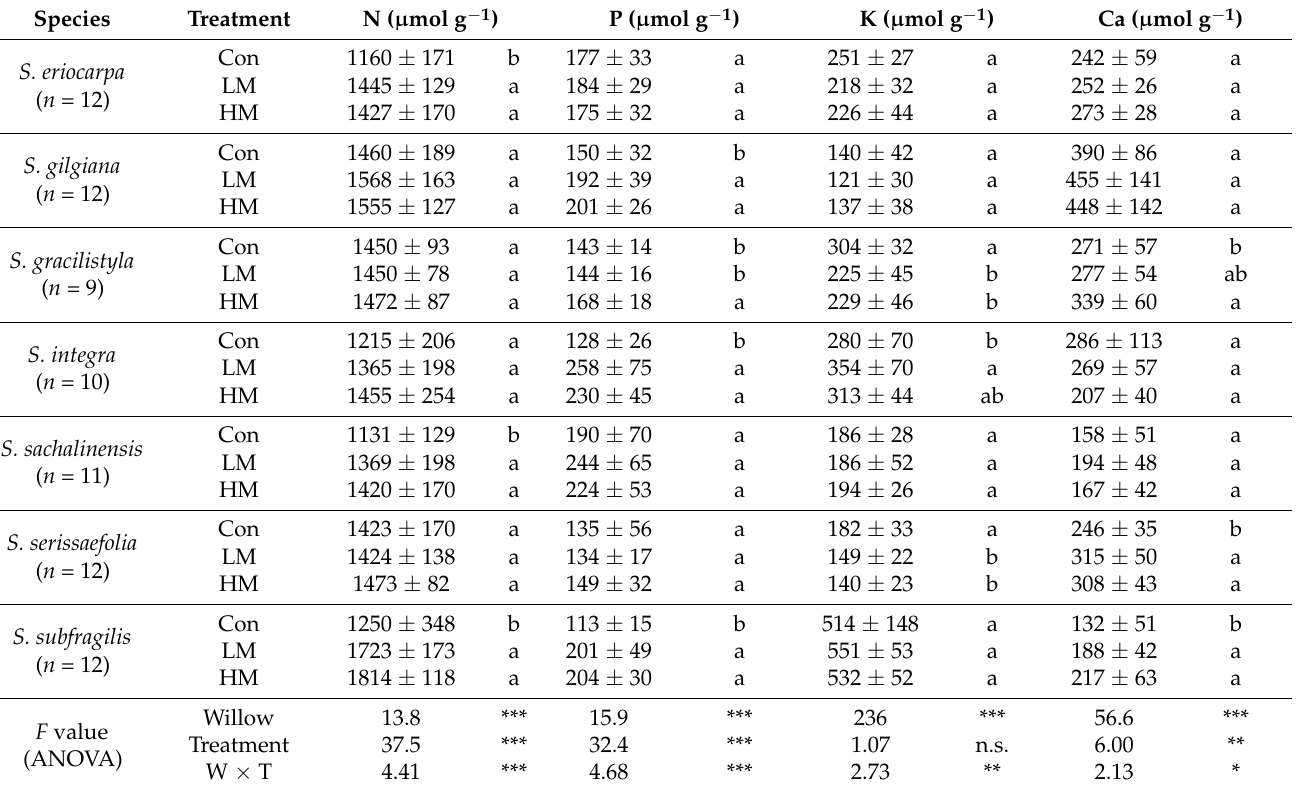
Table 6. Concentrations of chemical elements N, P, K and Ca (dry mass) in the leaves of individuals of seven willows grown under three treatments (mean ± SD). Asterisks indicate significant differ- ences among seven willows, three treatments, and their interaction (W × T) calculated by